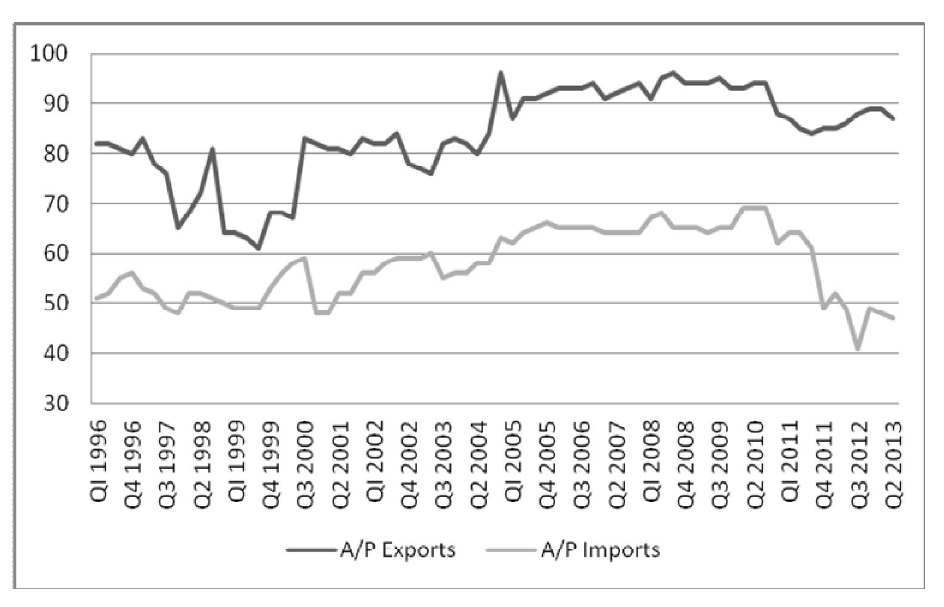
Graph 5: A/P Index for